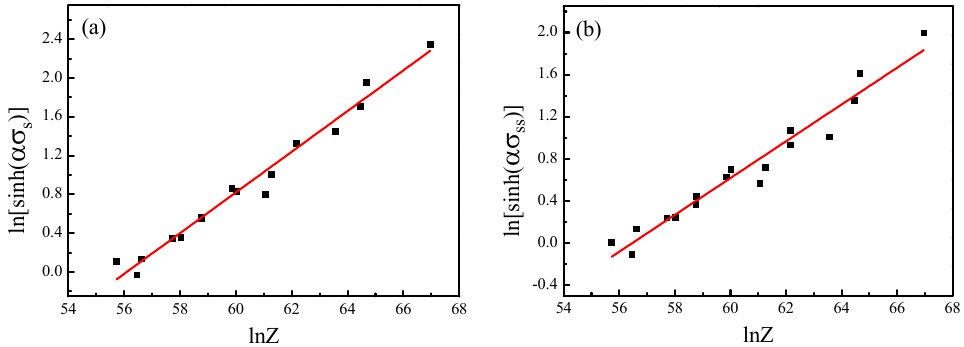
Figure 15. The plots of ( a ) ln r sinh p ασ s qs -ln Z ; and ( b ) ln r sinh p ασ ss qs -ln Z .